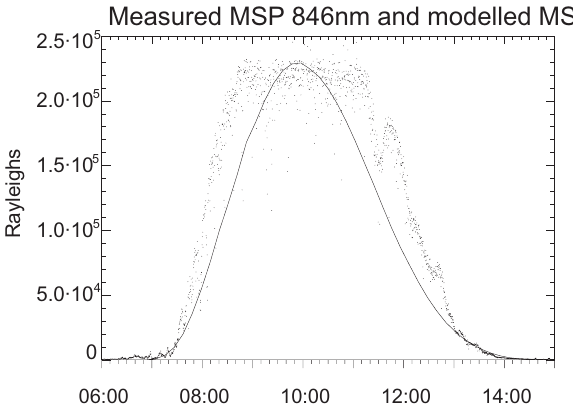
Fig. 9. Comparison between the UT variation of the observed MSP data (dots) at 845nm and the modelled signal (solid line) using an integrated vertical extinction of 0.037. The data are taken from an elevation of